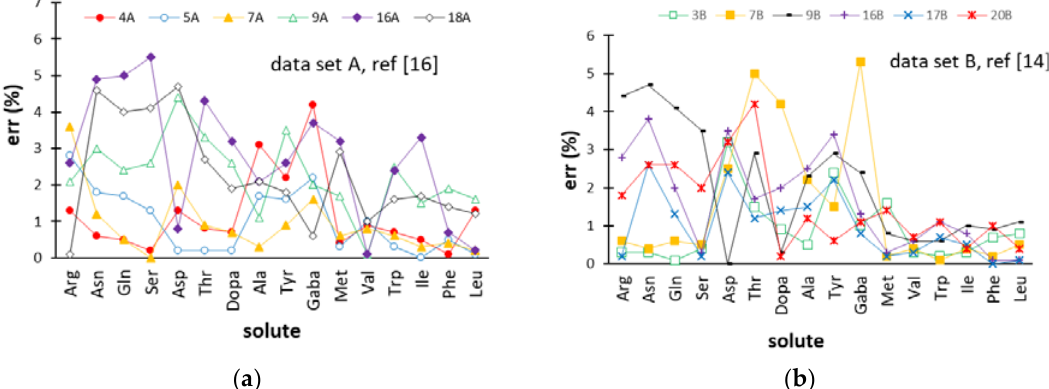
Figure 4. Percentage errors (err (%)) for the retention times of the amino acids provided by the retention models developed in References [14,16] for the external gradients (test set) of datasets A ( a ) and B ( b ). Abbreviations used for the amino acids are reported in Section 3.1. Gradient codes are specified in Table 1.